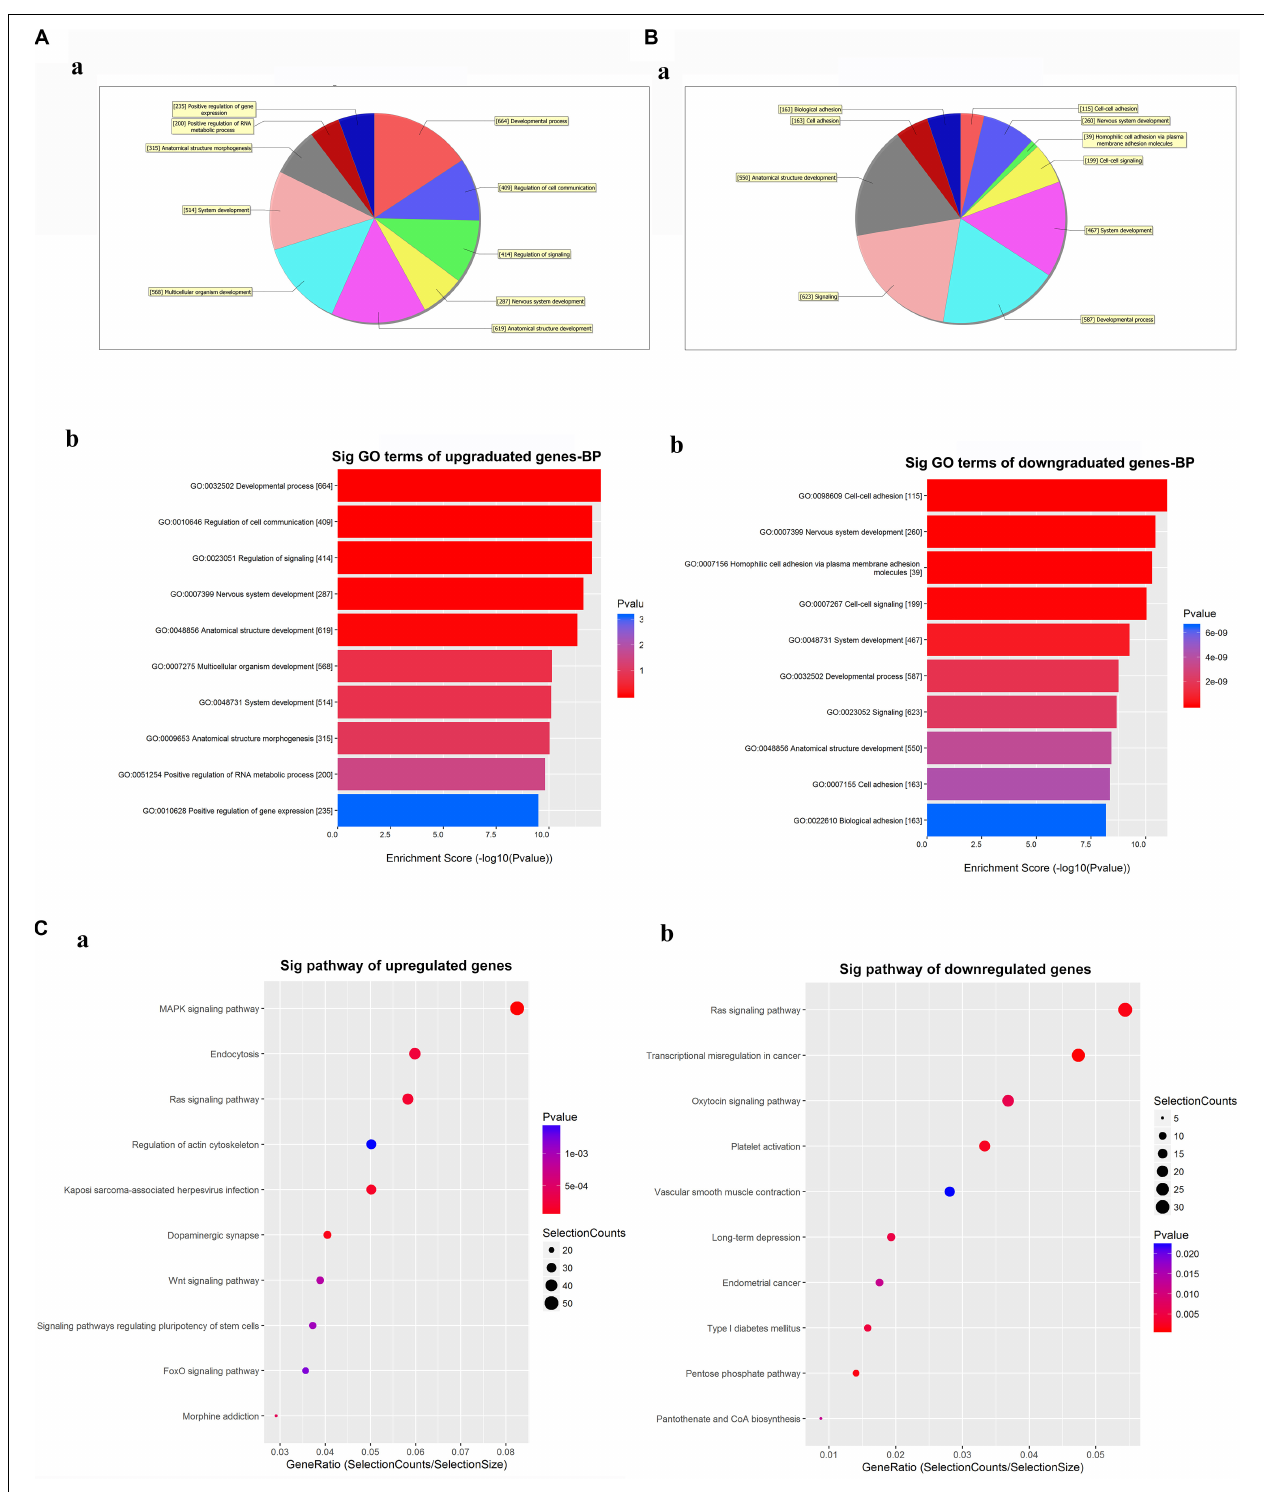
FIGURE 4 | Gene Ontology (GO) and Kyoto Encyclopedia of Genes and Genomes (KEGG) analyses for the top five upregulated and downregulated circRNAs. (A,B) GO analysis showing the biological processes enriched by the target genes of the top five upregulated and downregulated circRNAs: a —classification of the predicted biological processes; b —the top 10 significantly enriched genes based on their enrichment scores. (C) KEGG pathway analysis showing the top 10 significantly enriched pathways and their scores. GO, gene ontology; Sig, significantly; BP, biological processes. Selection Counts, Count of the genes’ entities directly associated with the listed pathway ID; Selection Size, the total number of the genes’